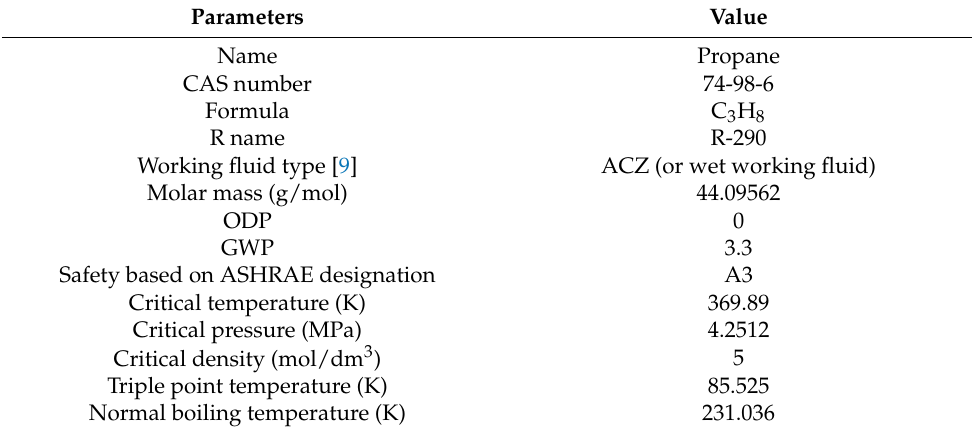
Table 1. Thermal properties and other parameters of propane